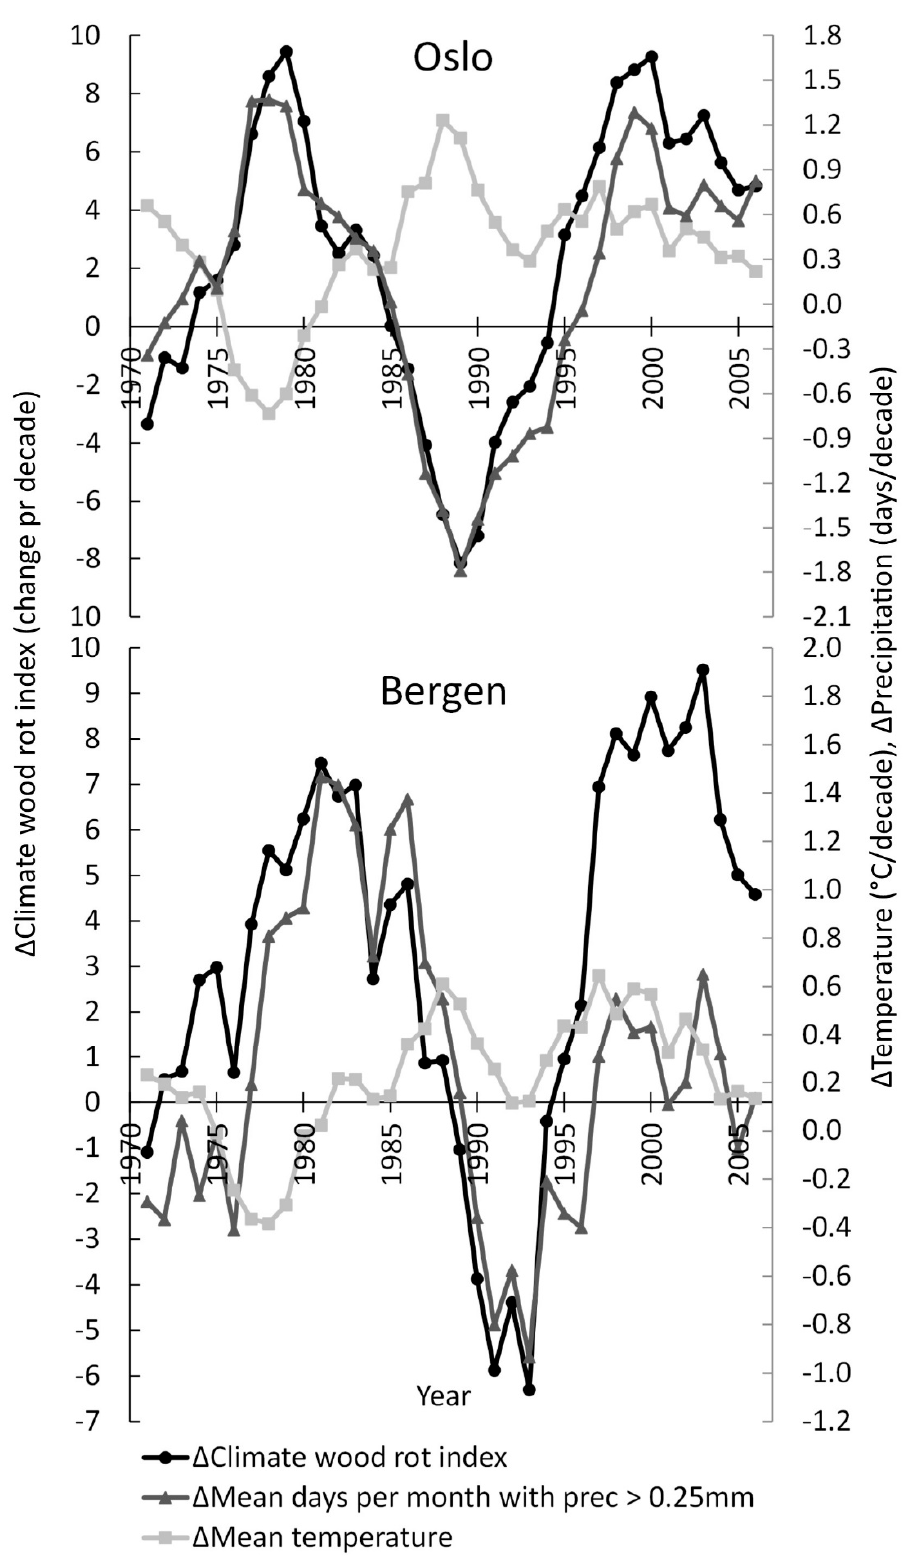
Figure 3. The change in the average decadal climate index, temperature, and precipitation days from the decade before to the decade after any year in Oslo and Bergen from 1961–2016. The changes are positive in the start and end of the period from 1961 through to 2015 but negative in the middle of the period for both Oslo and Bergen. The change in the decadal index was